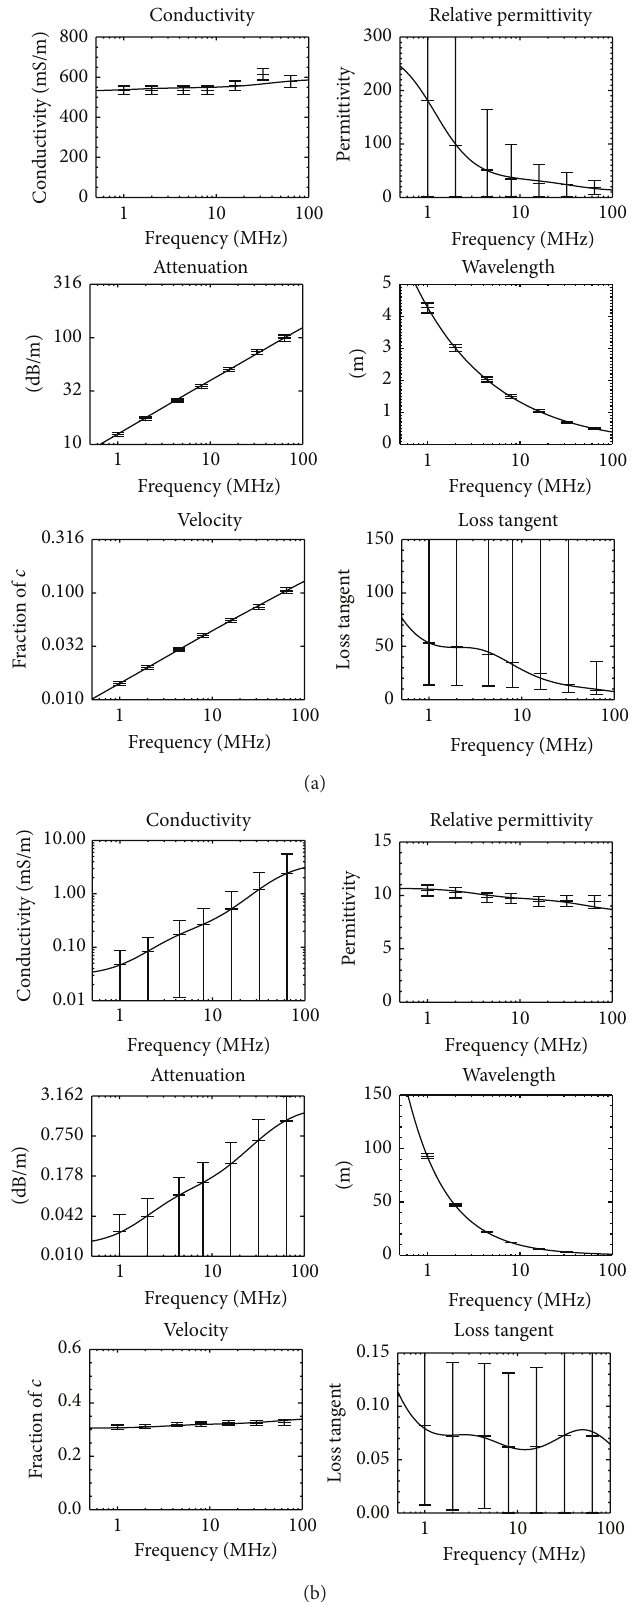
Figure 4: The electrical properties of a granite sample (a) and a sulphide sample (b) from Vogt [7]. Error bars are included and they are a result of the accuracy specification of the